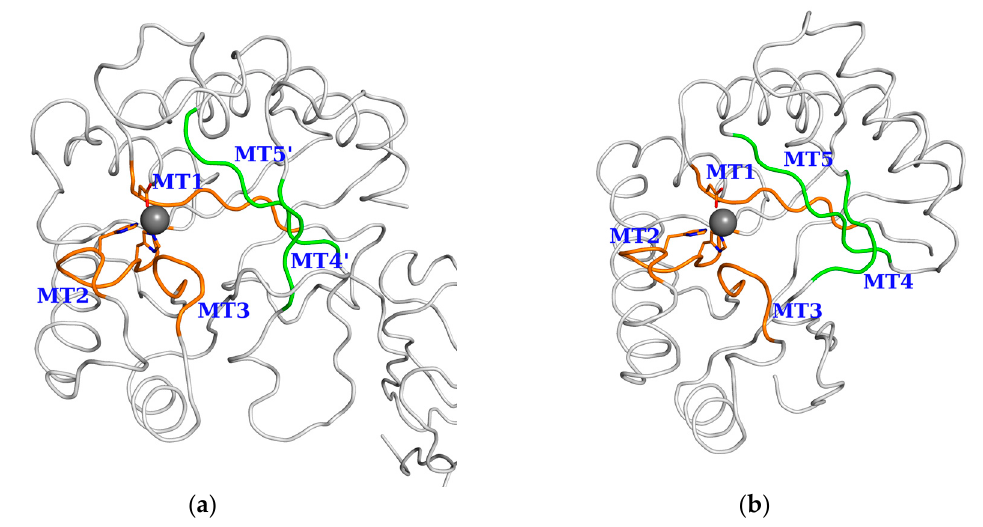
Figure 5. Location of conserved motifs MT1-MT5( ′ ) on the NodB domain of Ba0331 and Bc1974 structures. The elements shown in Figure 4 sequence alignment with orange (MT1, MT2, MT3, MT4 and MT5) and green bars (MT4 ′ and MT5 ′ ) are shown on the 3D C α representation of representative Group 1 and Group 2 structures. ( a ) Ba0331 and ( b ) Bc1974.